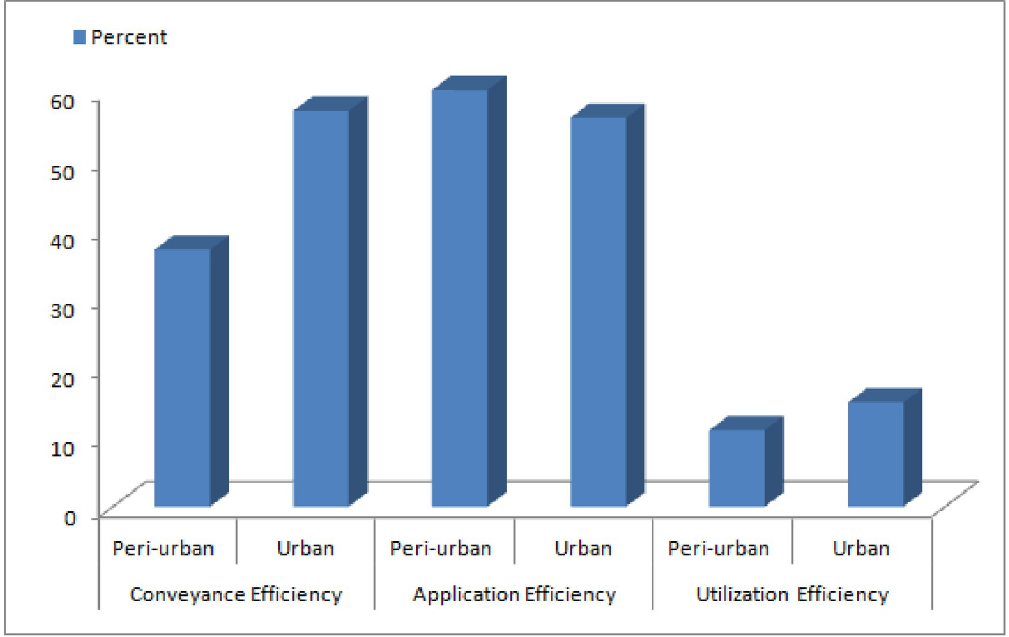
Fig 4. Efficiency of safe drinking water in urban and peri-urban